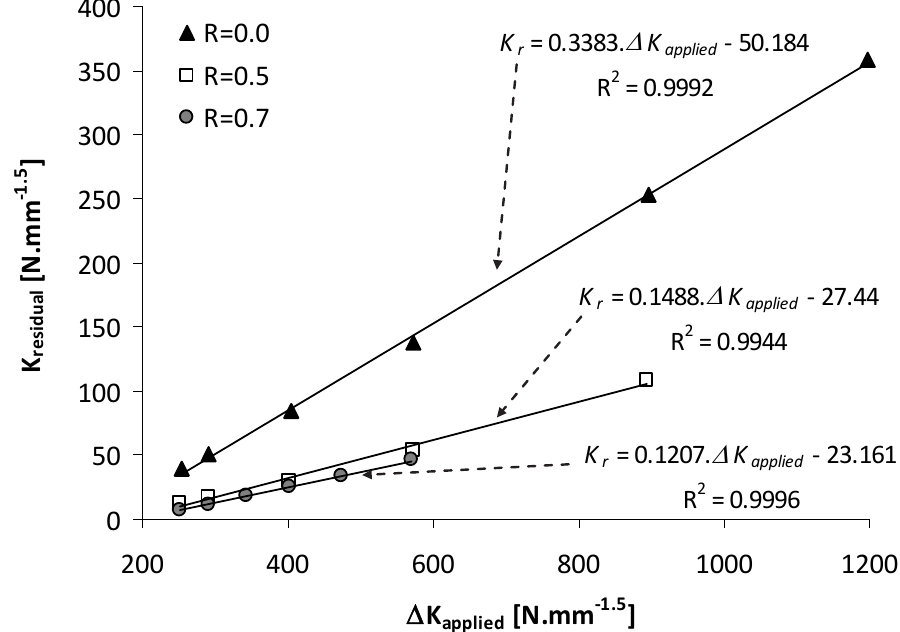
Figure 3. Residual stress intensity factor as a function of the  K applied for the CT geometry.